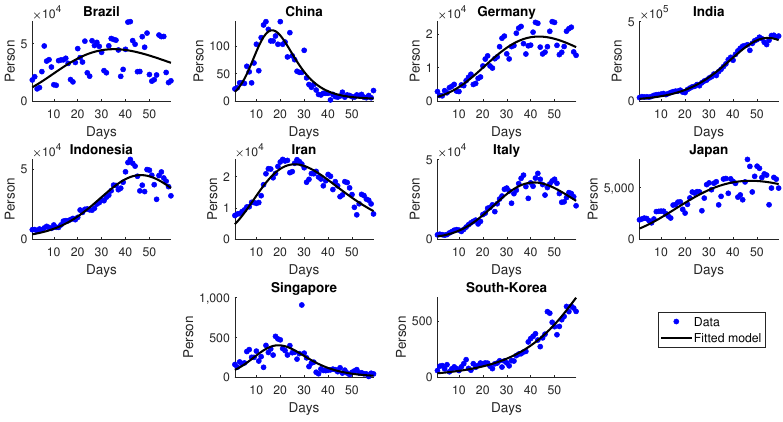
Figure 9. Simulation results of daily new cases γ T 1 ( ¯ K ) for the second wave